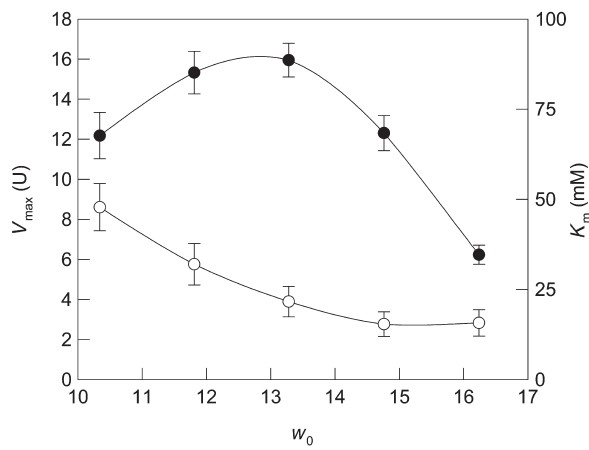
Figure 4. Effect of micellarwater content( w 0 = [H 2 O]/[surfactant])on the kinetic parameters of p NPPase from H. salinarum in reverse mi- celles (0.2 M CTAB and 1 M 1-butanol in cyclohexane): V max ( (cid:5) ) and K m ( (cid:4) ). The reaction was initiated by mixing reverse micelles con- taining enzyme with reverse micelles containing substrate. The buffer in the water pool was 100 mM Tris-HCl, pH 8.5, containing 100 mM NaCl, 20 mM 2-mercaptoethanol and 2 mM MnCl 2 . Temperature of the reaction was 40 °C. Protein concentration was 0.6 µg ml –1 .